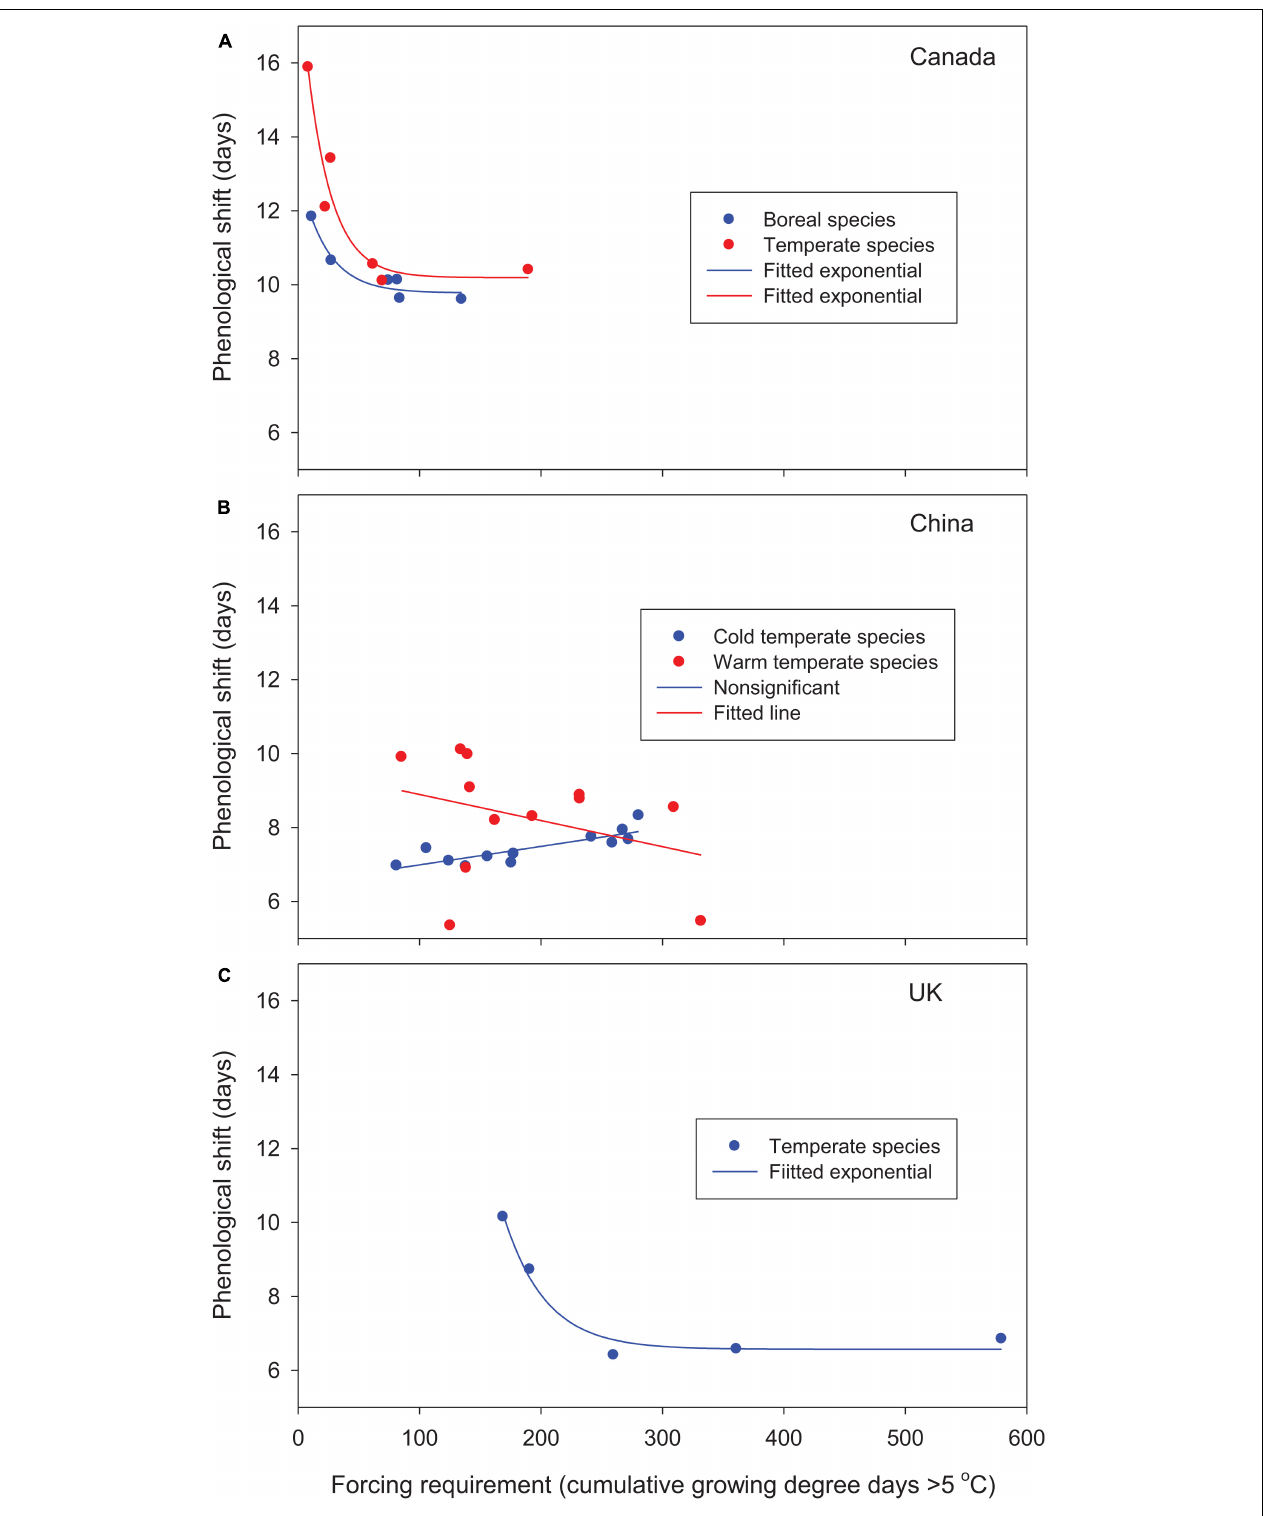
FIGURE 2 | Relationships between phenological shifts of woody species from the 1981–2010 baseline to future warmer (2 ◦ C uniform warming) climates and species’ forcing requirements (cumulative growing degree days > 5 ◦ C since January 1 at leaf-out) for (A) Canada, (B) China, and (C) the United Kingdom. Values are averaged by species/species groups over 30 years and 9–12 locations under baseline and future warmer climates. Species forcing requirements range from low to high for early to late season species.